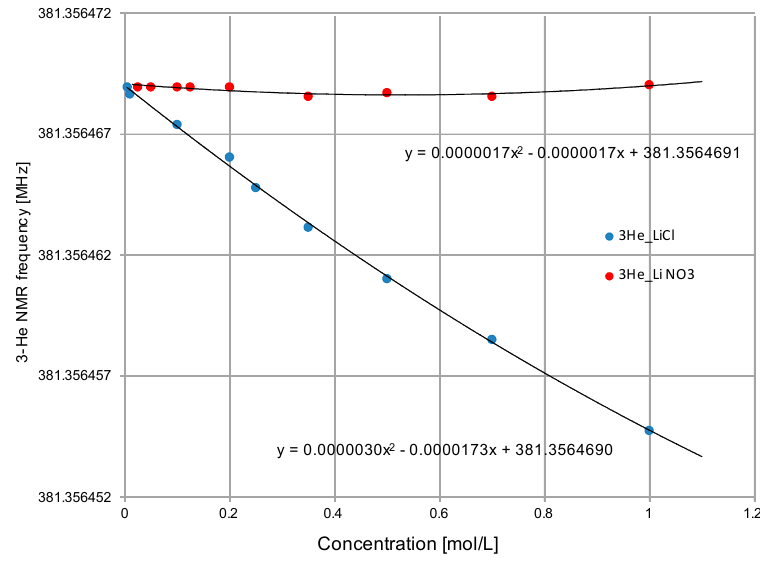
Figure 2. The 3 He NMR frequencies of helium atoms dissolved in water solutions of LiCl (lover curve) and LiNO 3 (upper curve) against salt concentration. Intersection of the axis represents frequency value at infinite dilution.